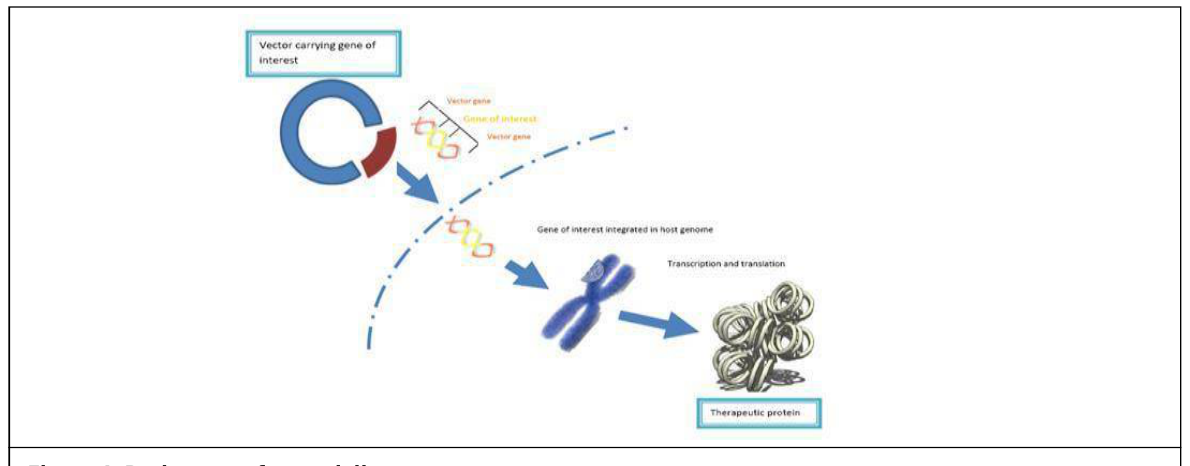
Figure 1: Basic steps of gene